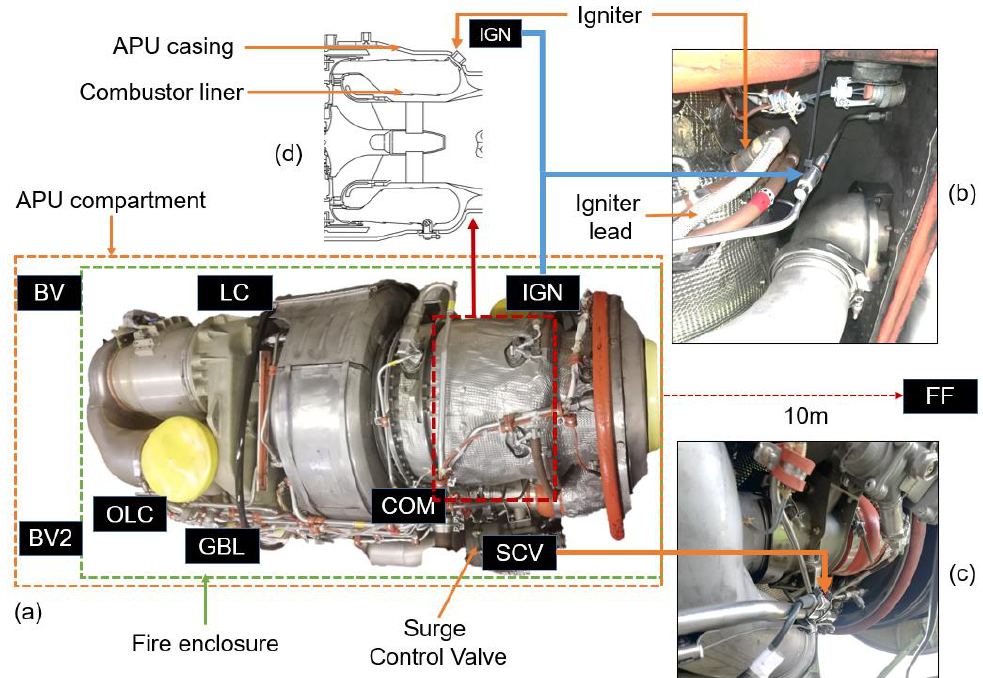
Figure 3. Experimental setup: ( a ) APU and sensor locations; ( b ) IGN microphone location; ( c ) SCV microphone location; ( d ) cross-sectional view of the APU combustor, adapted from [10].